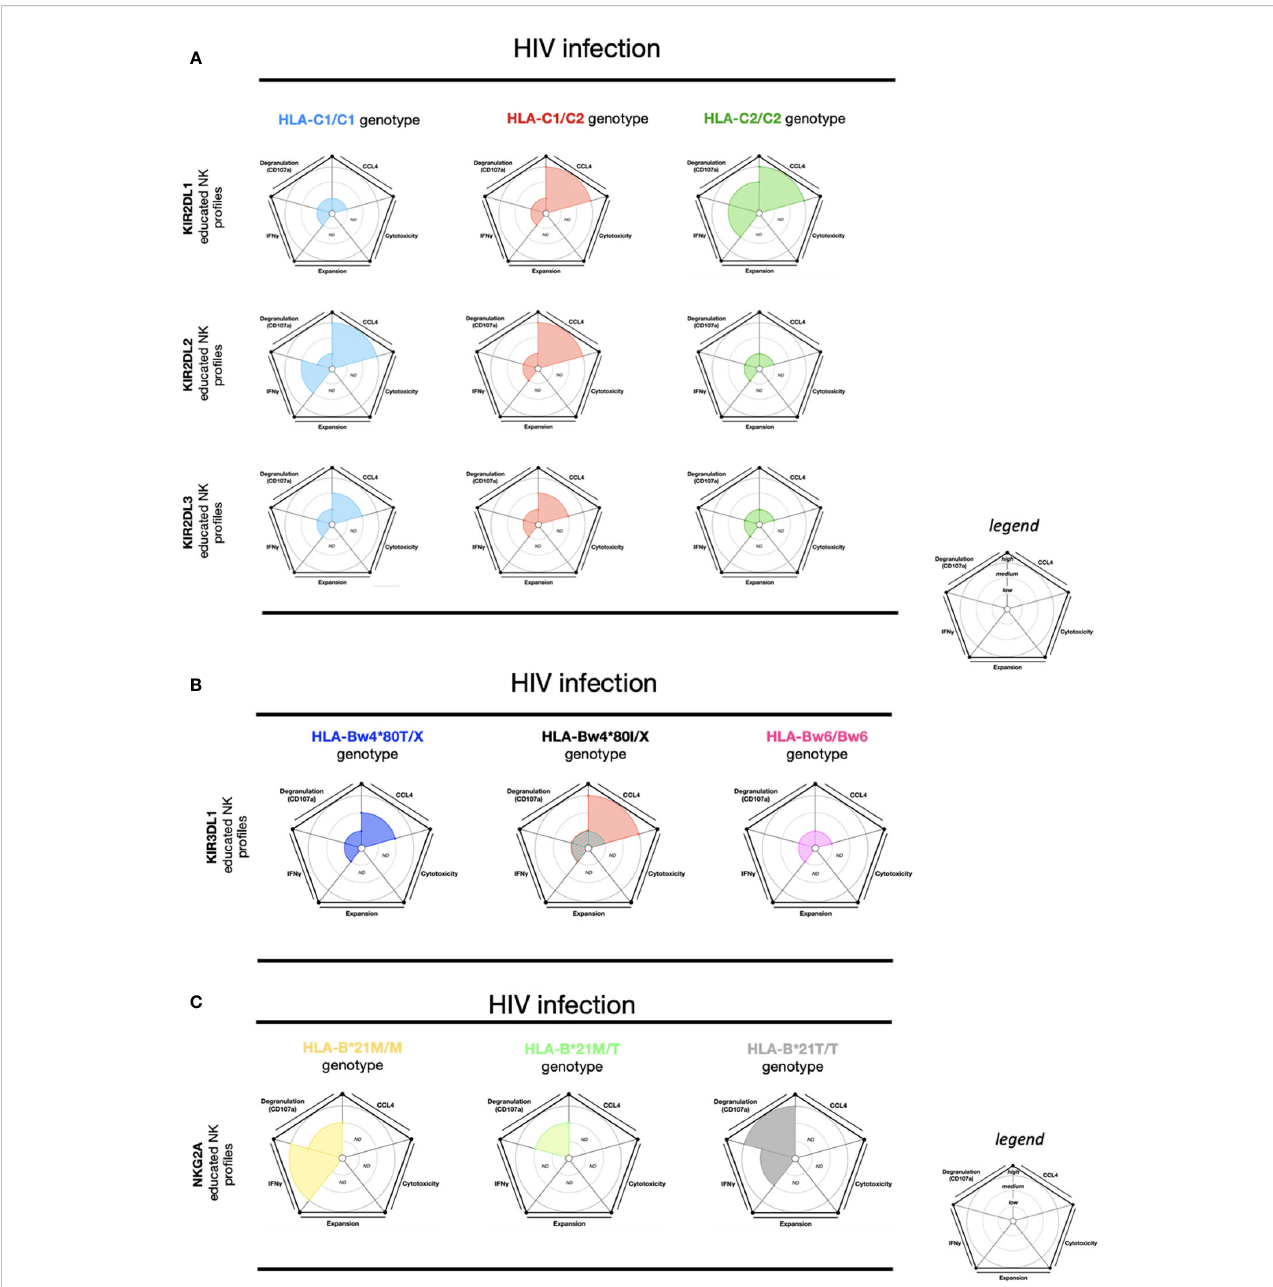
FIGURE 2 NK cell education pro fi les concerning to HIV infection. The different colors each represent a speci fi c-NKR educated NK pro fi le. Each educated NK pro fi les are de fi ned by fi ve factors (degranulation, CCL4, IFN g , cytotoxicity, and expansion). Each factor is described by the size of its slice on the pie chart according to three levels of reactivity (low, medium, and high). (A) KIR2DL1 educated NK cells, KIR2DL2 educated NK cells, and KIR2DL3 educated NK cells present three educated NK pro fi les respectively associated with HLA-C1/C1, HLA-C1/C2, and HLA-C2/C2 genotypes. (B) KIR3DL1 educated NK cells present four educated NK pro fi les according to HLA-Bw4/Bw4, HLA-Bw4/Bw6, and HLA-Bw6/Bw6 genotypes. HLA-Bw4/BwX is distinguished by three different backgrounds: HLA-Bw4*80T, HLA-Bw4*80I with high expression of KIR3DL1, and HLA-Bw4*80I with low expression of KIR3DL1. (C) NKG2A educated NK cells present three educated NK pro fi les according to HLA-B-21M/M, HLA-B-21M/T, and HLA-B-21T/T genotypes. ND, no data is described. The ribbed area describes a superposition of two areas relative to the colors exhibited. The NK educated reactivity was adapted from in vitro HIV-infected CD4 cell stimulation assays, previously described (21, 72). Except for the Figure 2C, the NK educated IFN g reactivity represented in these charts was taken via in vitro anti-CD20 Raji cell stimulation